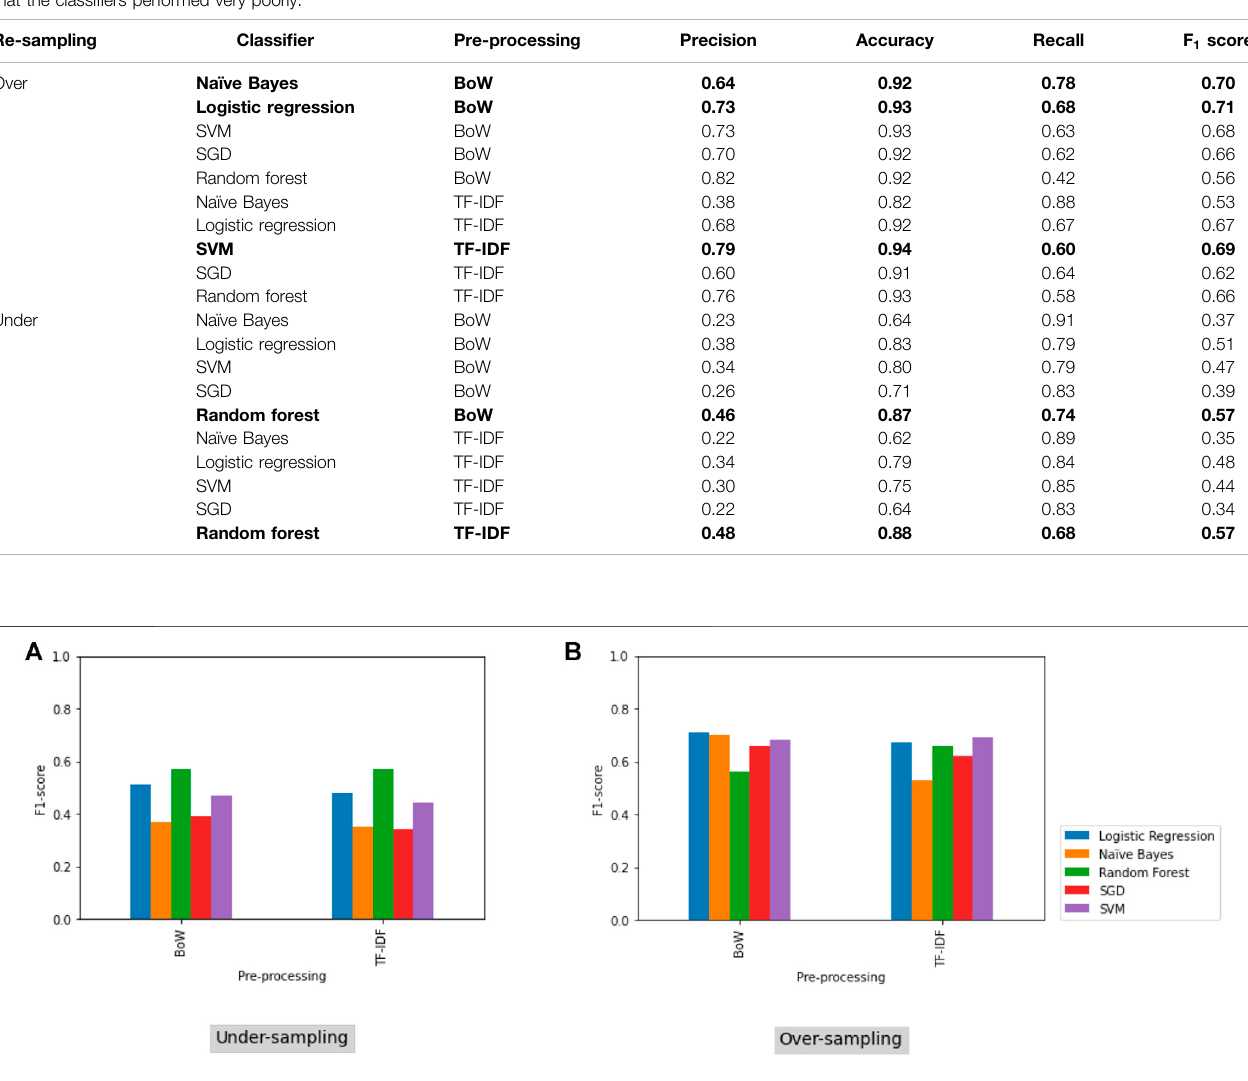
Frontiers in Physics |